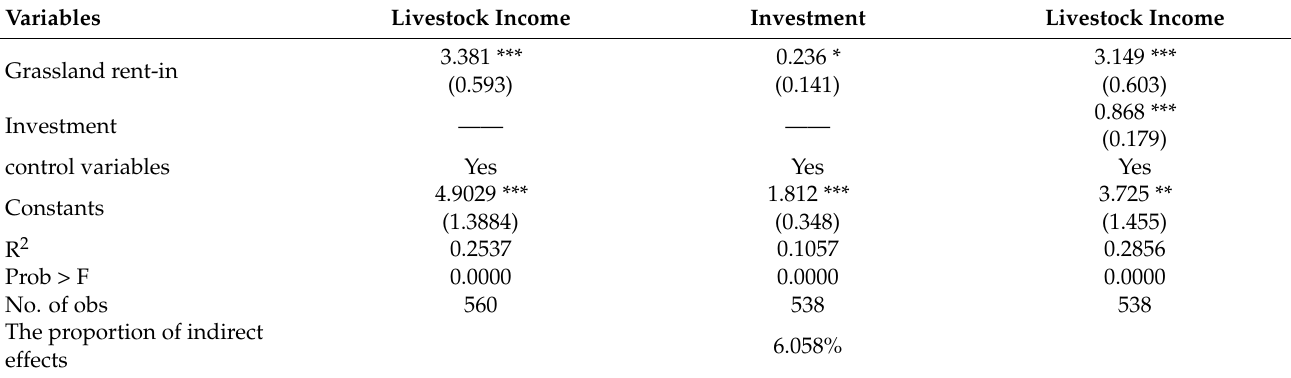
Table 8. Mediating effect test of grassland